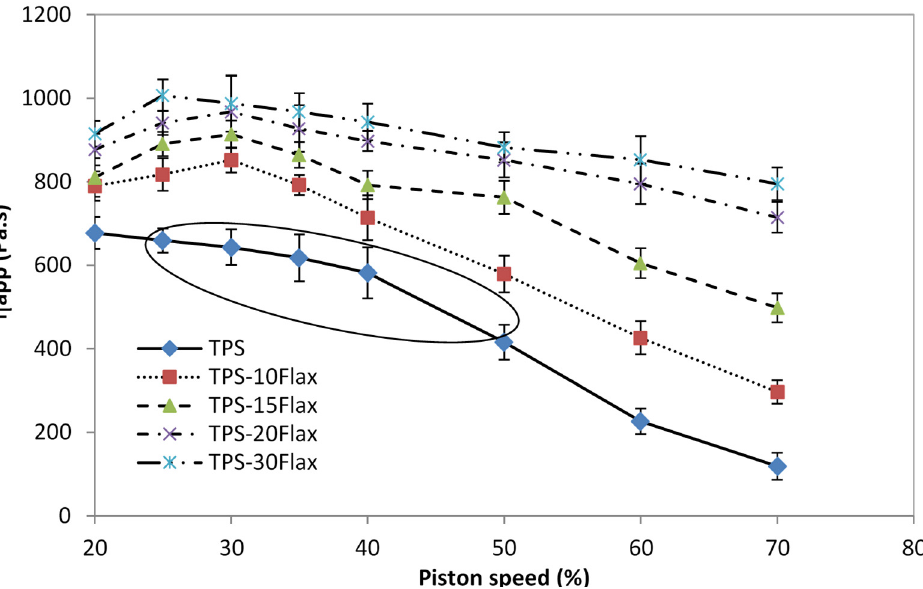
Figure 7. Variation in the apparent viscosity of the TPS/flax shives mixtures (% percentage) as a function of the shear rate (temperature 145 °C) .